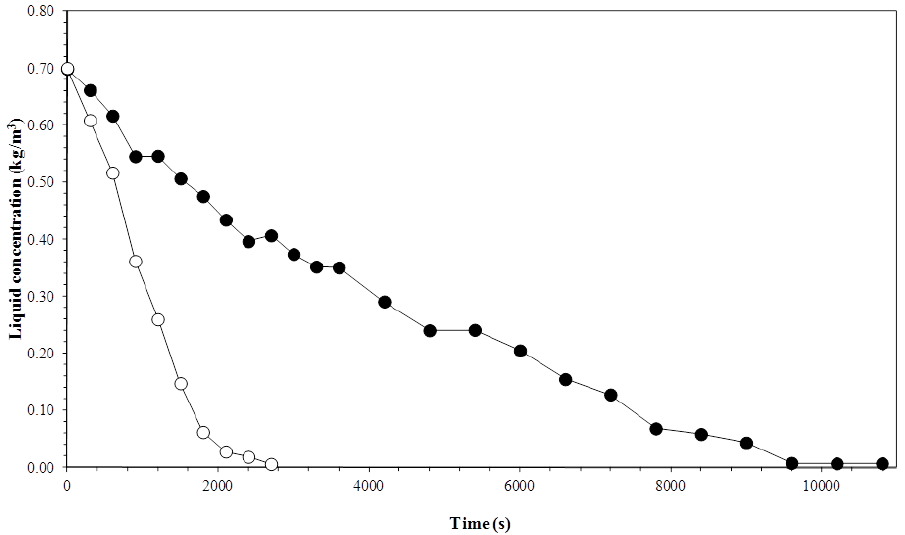
Figure 5. Variation in the liquid column concentration with time and gas flow rate. Experiment conditions: initial biosurfactant concentration of 0.7 kg m − 3 and temperature of 35 °C. Gas flow rate: ( ) 3.3 × 10 − 7 m 3 s − 1 ; ( ) 1 × 10 − 6 m 3 s − 1 (cid:35)